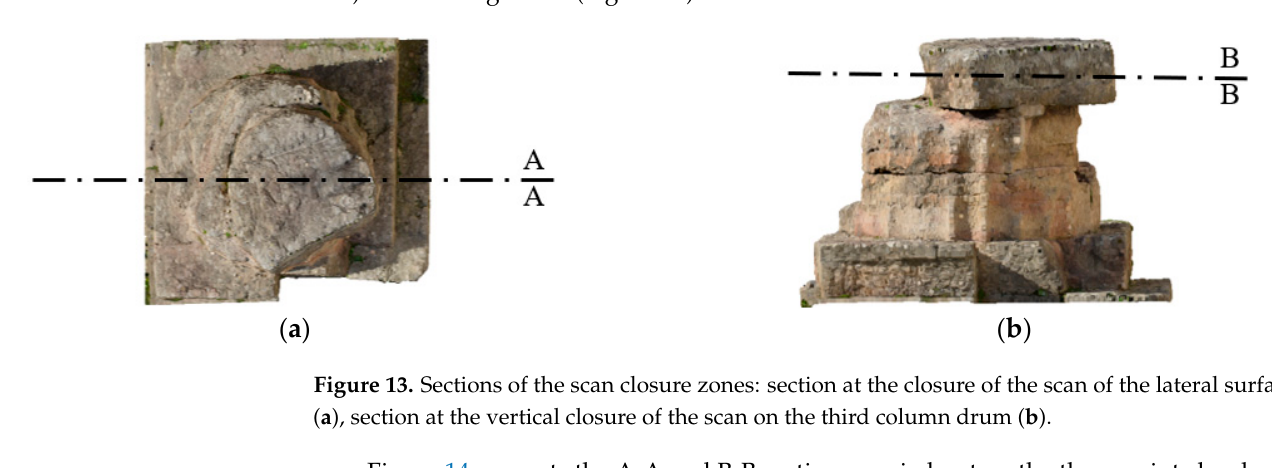
( f ) Figure 14. Sections of the point cloud in the closure zones: vertical section (A-A) of the point cloud with resolution 1 cm ( a ), vertical section (A-A) of the point cloud with resolution 1.5 cm ( b ), vertical section (A-A) of the point cloud with resolution 2 cm ( c ), horizontal section (B-B) of the point cloud with resolution 1 cm ( d ), horizontal section (B-B) of the point cloud with resolution 1.5 cm ( e ), hori- zontal section (B-B) of the point cloud with resolution 2 cm ( f ).